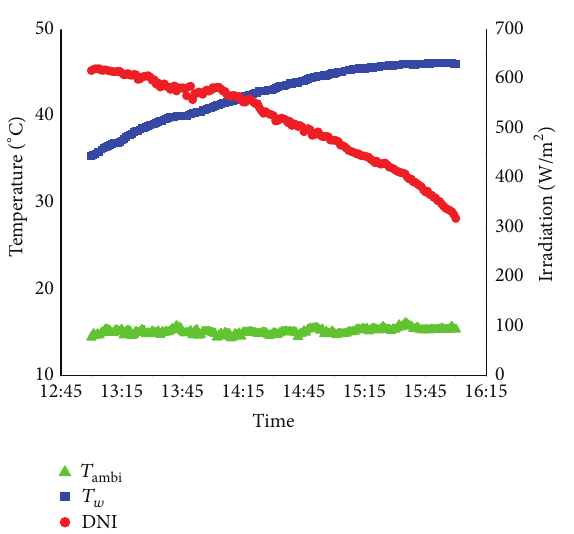
Figure 8: Photovoltaic and thermal output of the HCPV/T system in the testing period.